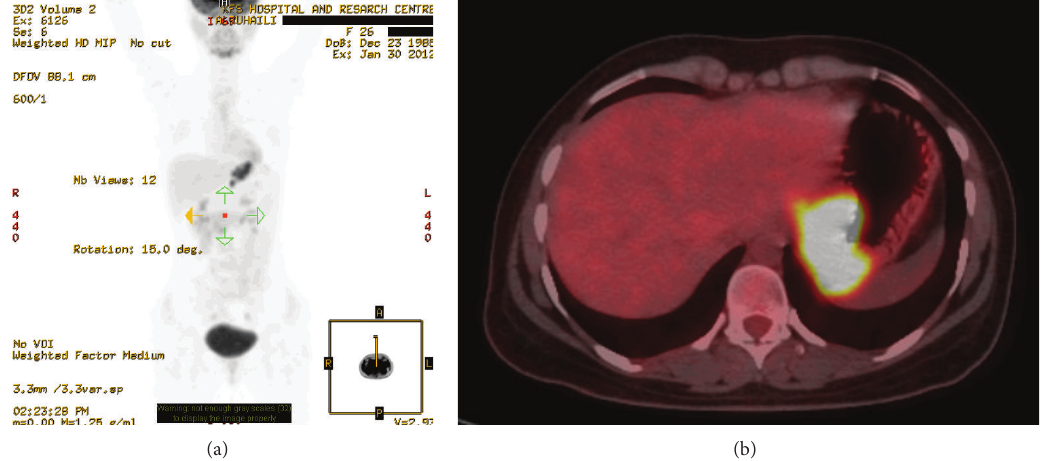
Figure 2: Positron emission tomography (PET) (a) and transverse-section positron emission tomography-computed tomography (PET-CT) (b) scans: showing hypermetabolic fluorodeoxyglucose- (FDG-) avid mass lesion in gastric fundus and extending into gastric cardia and lower gastroesophageal junction. In addition, it was associated with a few hypermetabolic FDG-avid lesions in the gastrohepatic junction, indicating lymph node metastases. No evidence of distant metastasis was